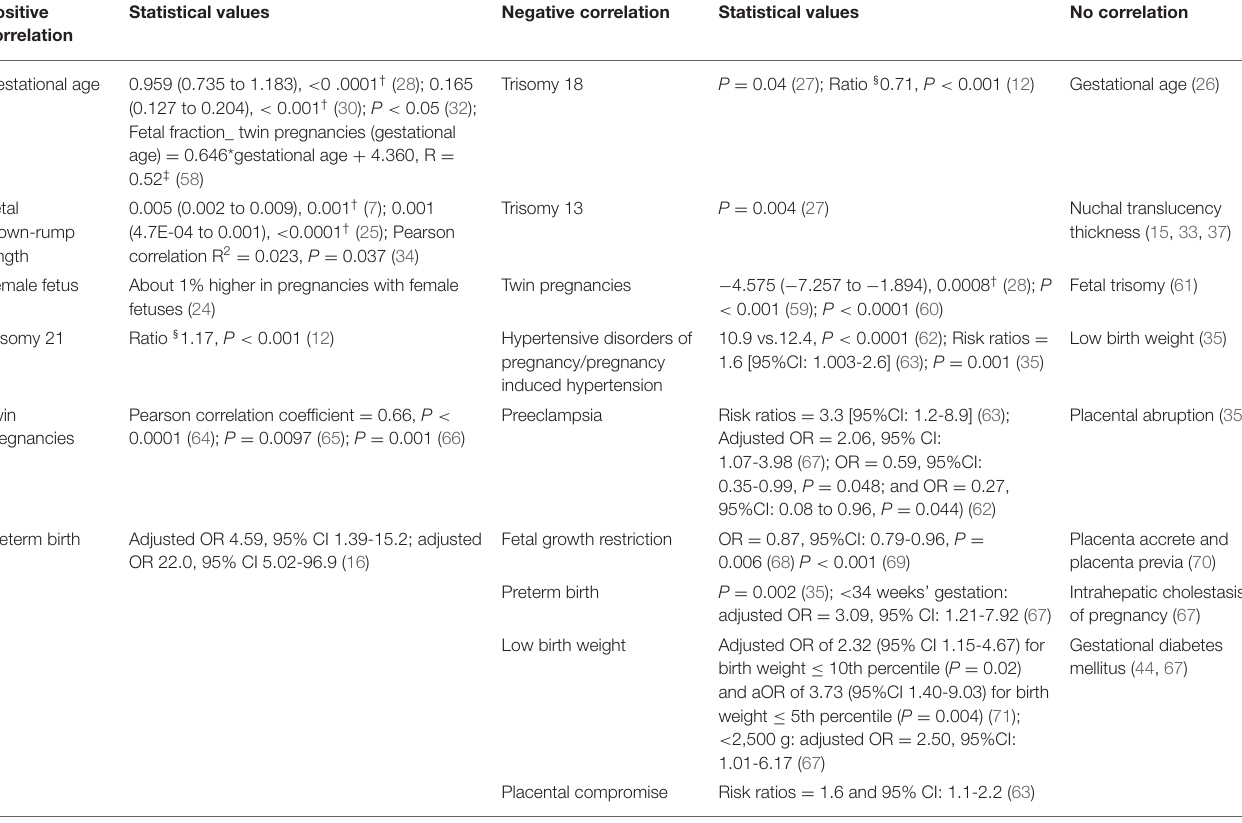
95% CI, 95% confidence interval. † Regression coefficient (95% confidence interval), P; ‡ The corresponding regression equations; § Ratio, median fetal fraction for subgroup/median fetal fraction for euploid pregnancies. ¶ OR, odds ratio. Significant at P <